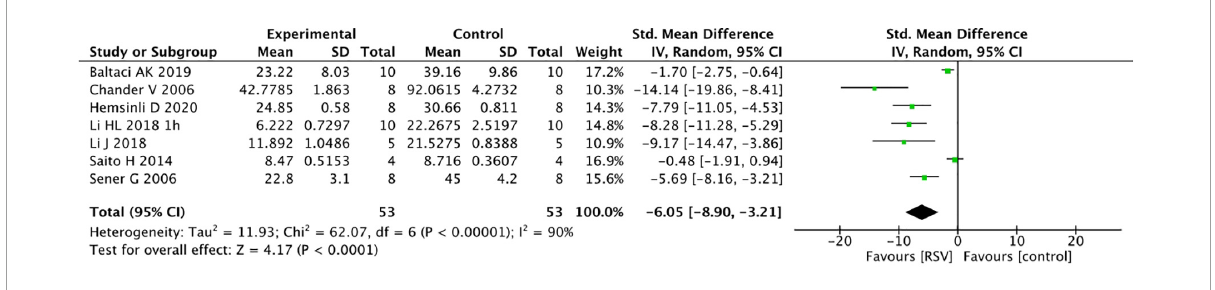
FIGURE4 Forest plot for the effects of resveratrol on